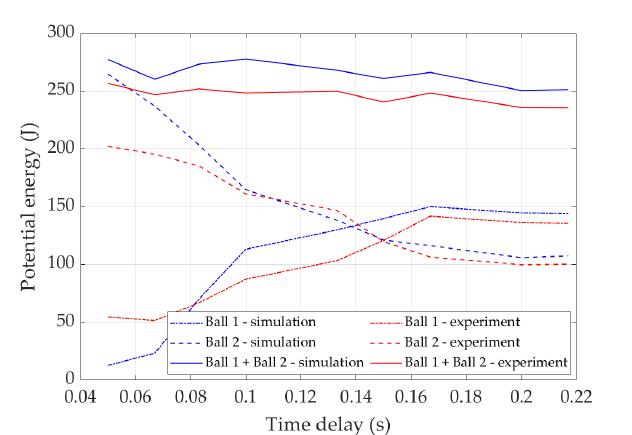
Figure 14. Potential energy of balls after double bounce.